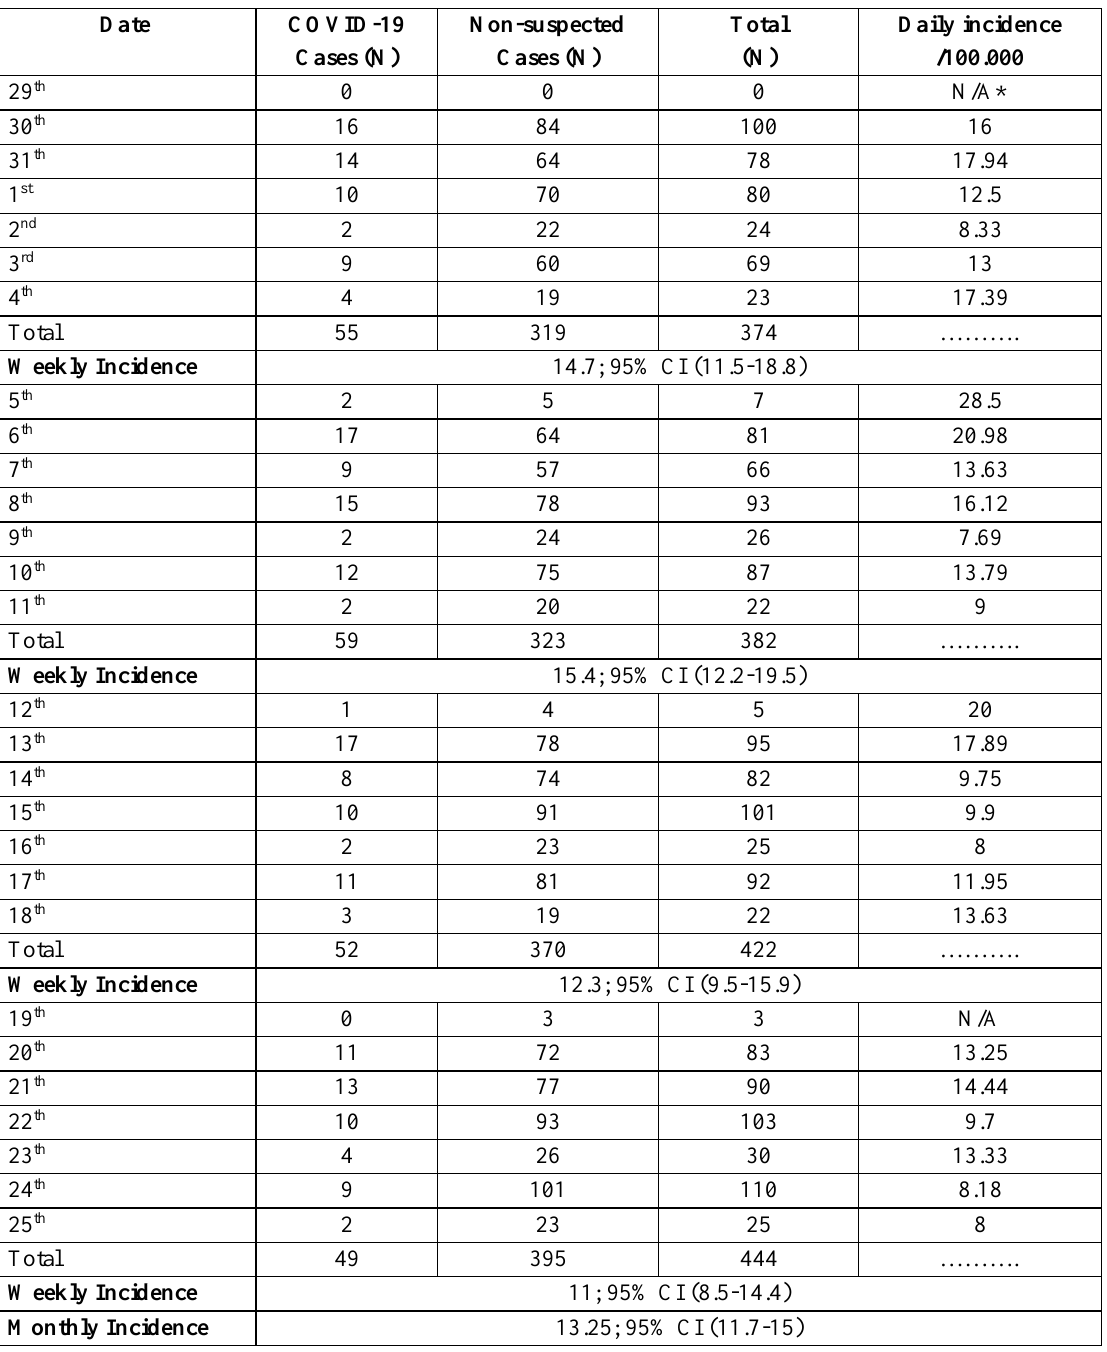
Table 2. Incidence of moderate and severe COVID-19 at ZUH during February